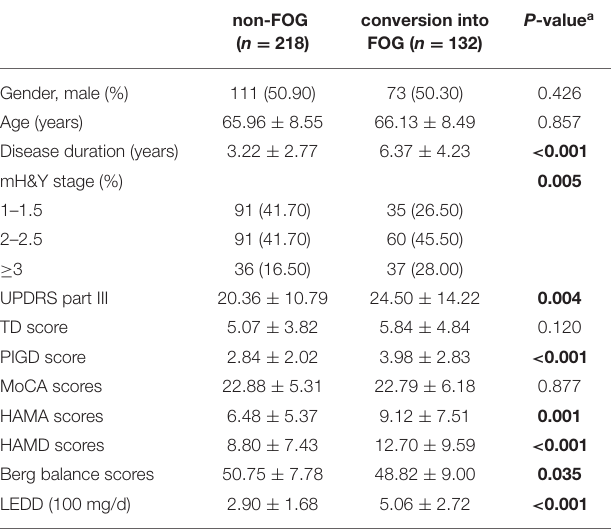
TABLE 1 | Clinical characteristics of the study population at